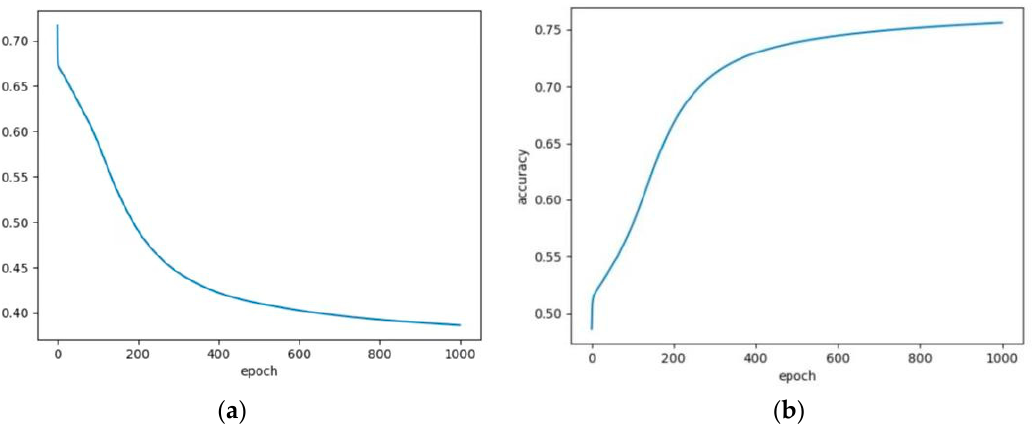
Figure 5. Model prediction: ( a ) the average entropy loss varies with training rounds; ( b ) average prediction accuracy varies with training epochs.